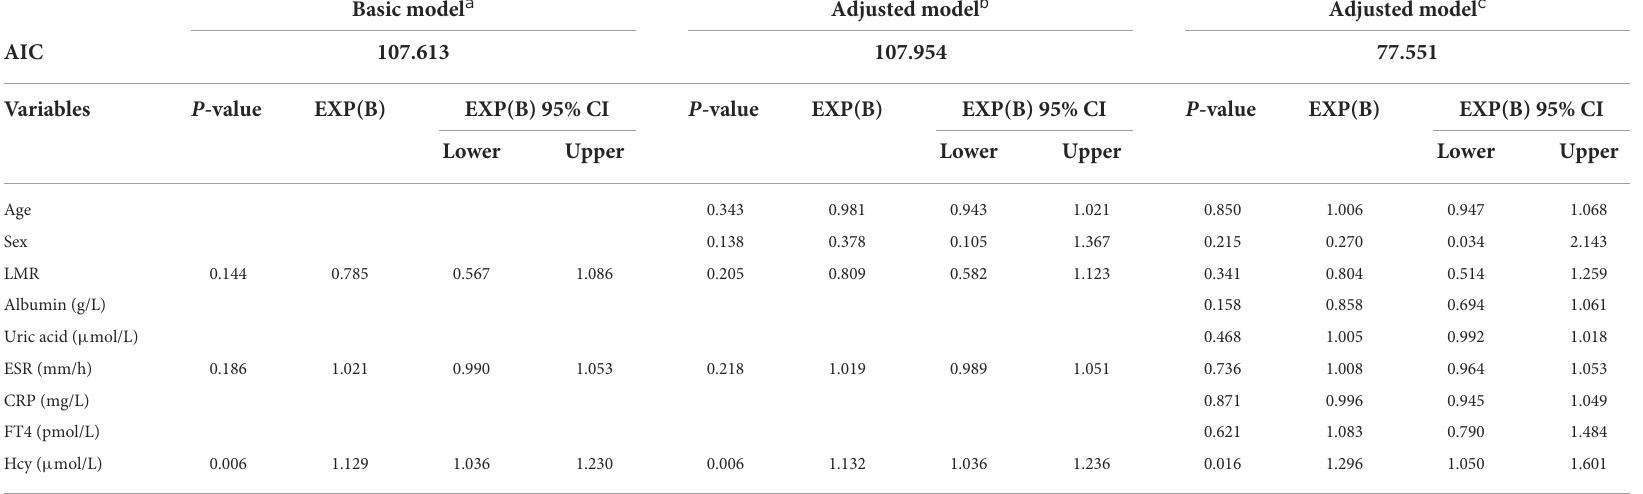
TABLE 7 Multivariable logistic regression analysis of factors differentiating patients of first-attack NMOSD with and without